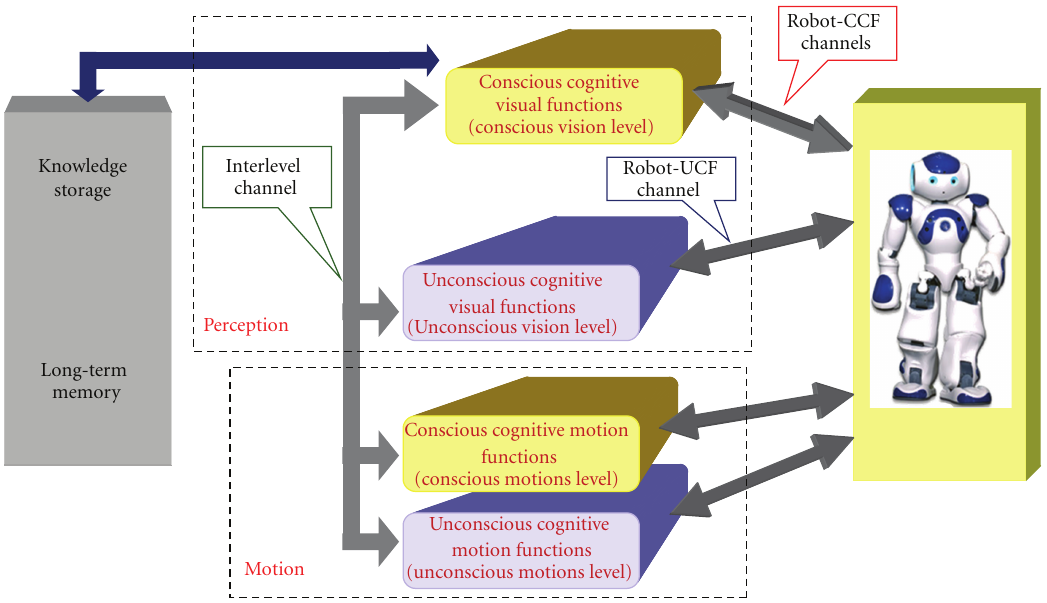
Figure 3: Bloc diagram of motion-perception-based robot cognitive control